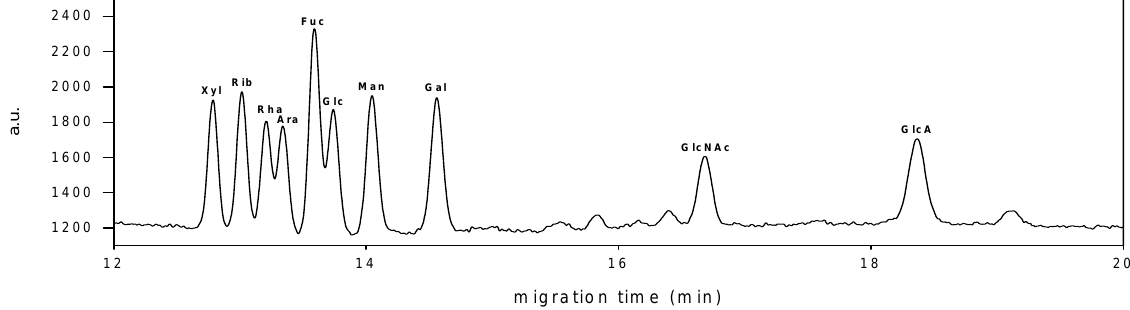
X-ray crystallographic data: The CCDC deposition number of compound 1 is CCDC 768210. This data can be obtained free of charge via www.ccdc.cam.ac.uk/conts/retrieving.html. Figure 3. Capillary electrophoresis chromatograph of pento- and hexo-naphthimidazoles on uncoated fused-silica capillary (50/60.2 cm × 50 μ m) at 30 °C. The mobile phase is Tris buffer (500 mM, pH 2.5) at a flow rate of 0.8 mL/min. The UV detection wavelength is 326 nm. The sample is a mixture of aldonaphthimidazoles, including those derived from D - xylose ( 1 , peak 1), D -ribose ( 2 , peak 2), L -rhammose ( 3 , peak 3), D -arabinose ( 4 , peak 4), L -fucose ( 5 , peak 5), D -glucose ( 6 , peak 6), D -mannose ( 7 , peak 7), D -galactose ( 8 , peak 8), N -acetyl- D -glucosamine ( 9 , peak 9) and D -glucuronic acid ( 10 , peak 10) at a concentration of 10 ppm for each